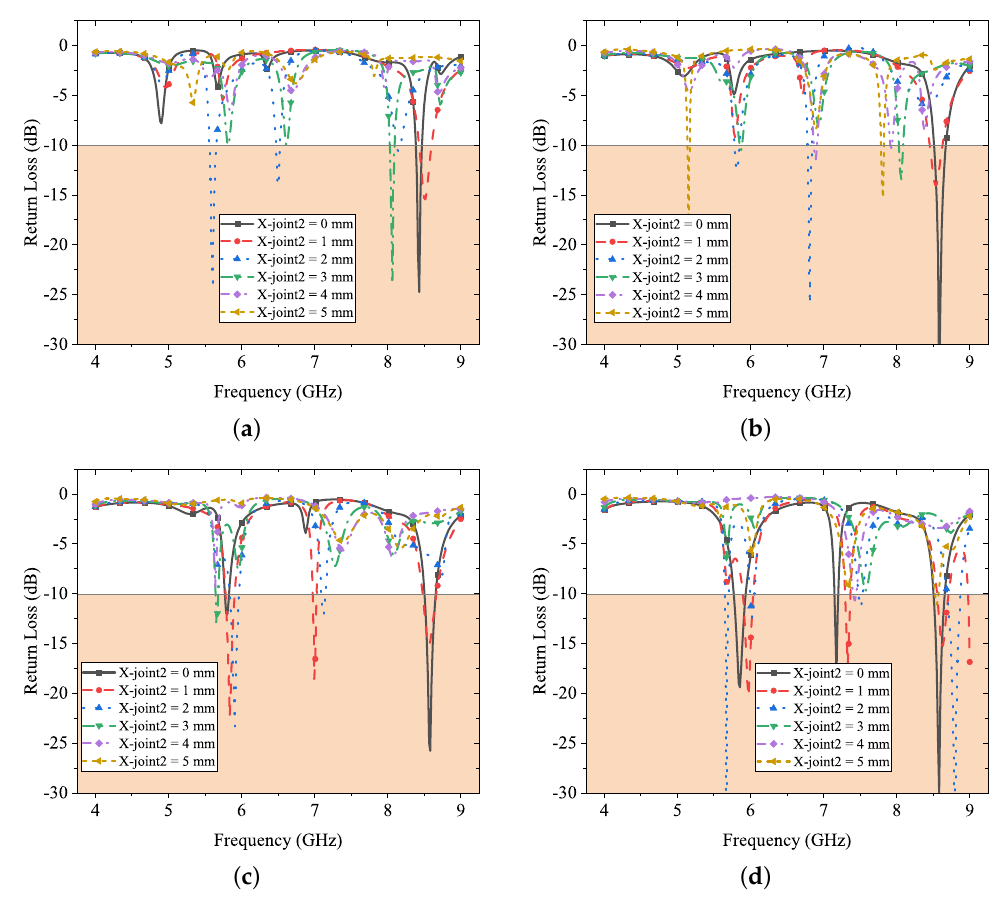
Figure 7. Effect of the joint2 position ( X joint 2 ) on return loss performance. ( a ) Parametric sweep when L joint 2 = 1 mm; ( b ) Parametric sweep when L joint 2 = 3 mm; ( c ) Parametric sweep when L joint 2 = 5 mm; and ( d ) Parametric sweep when L joint 2 = 7 mm.